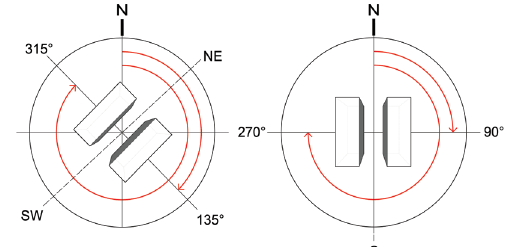
Figure 1. The calculation of canyon azimuthal directions. A NE- SW-oriented canyon (left) and a N-S-oriented canyon (right) Firstly, the DEM was pre-processed to set all the ground pixels to NoData. Then, the Euclidean Direction tool in ArcMap 10.5 was used to calculate the direction that each ground pixel center (NoData), in the DEM, is from the closest pixel with a valid value (i.e. facade pixel) as shown in Figure